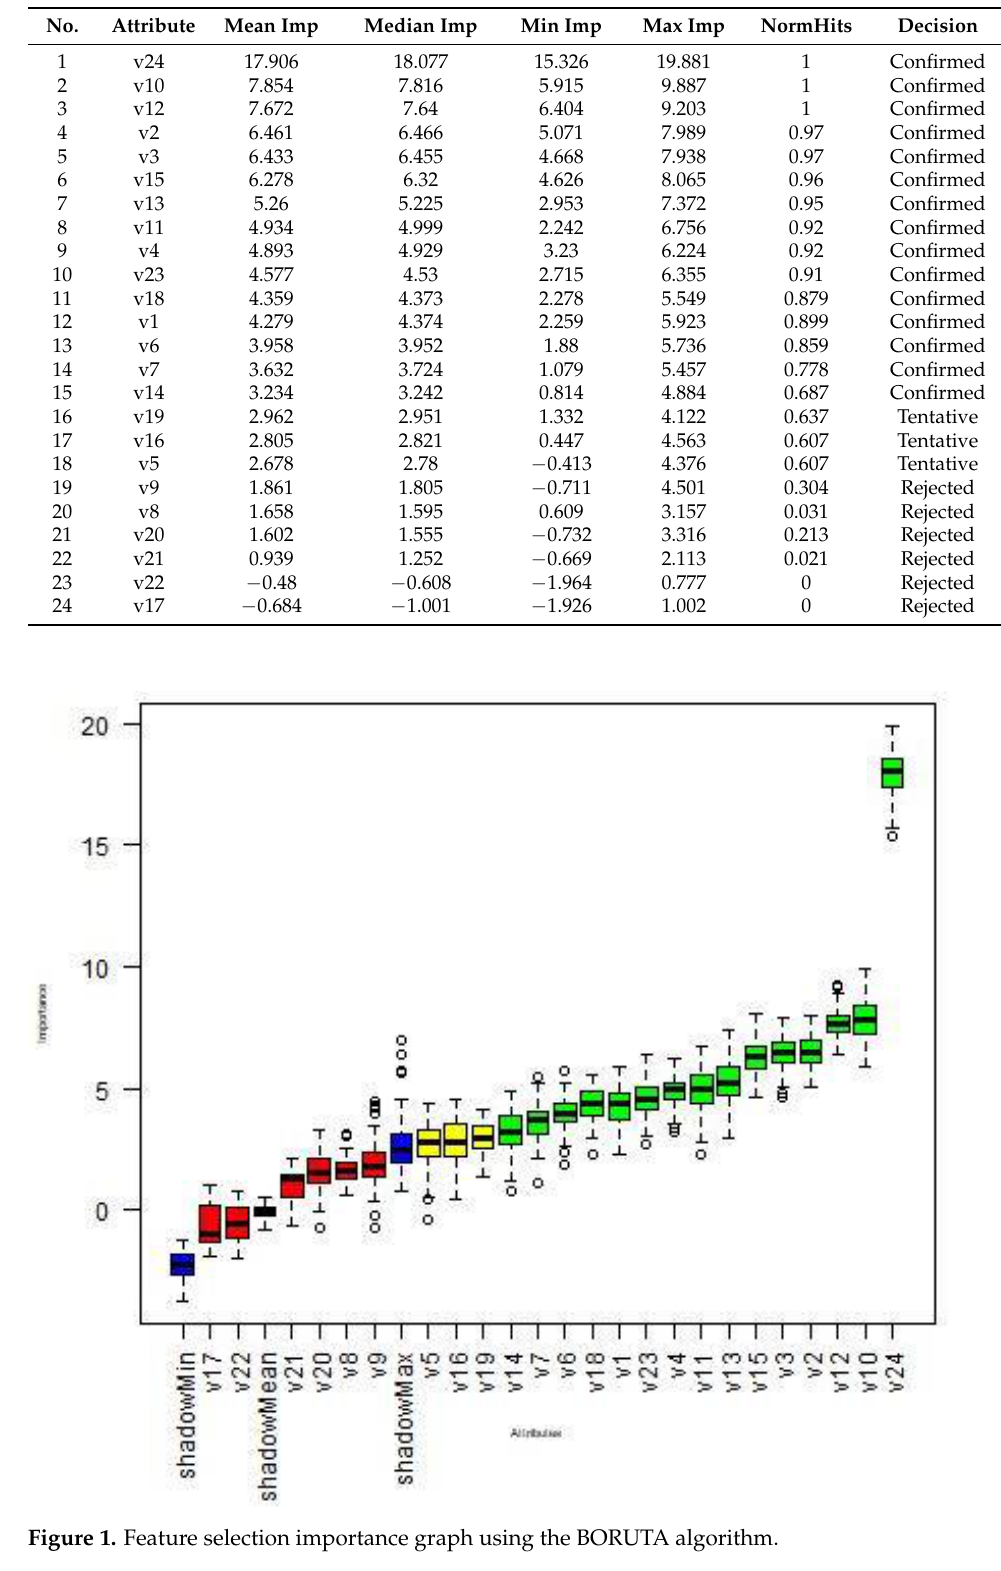
Table 2. The result of the feature selection process.